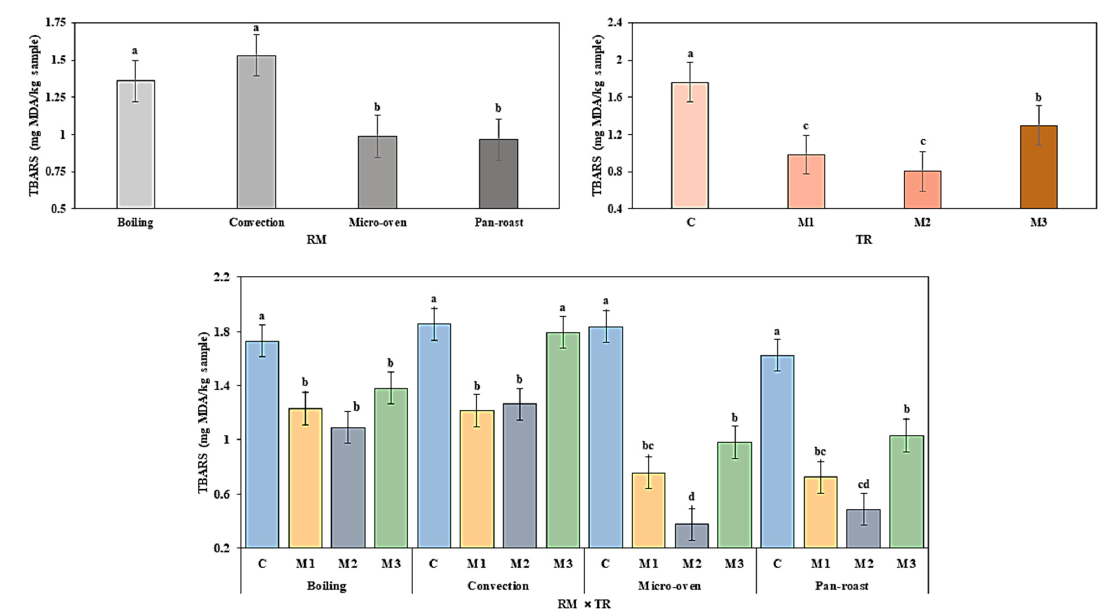
Figure 3. Effect of different reheating condition on thiobarbituric acid-reactive substances (TBARS) of nutmeg extract enriched precooked beef meatballs during frozen storage. RM, reheating method; ST, storage time; C, antioxidant-free meatballs; M1, 0.02% BHT treated; M2, 0.02% nutmeg extract treated; M3, 0.02% nutmeg powder treated. a-d Means with different superscript small letters differ significantly ( p < 0.05) in TBARS among treatments at different reheating method.